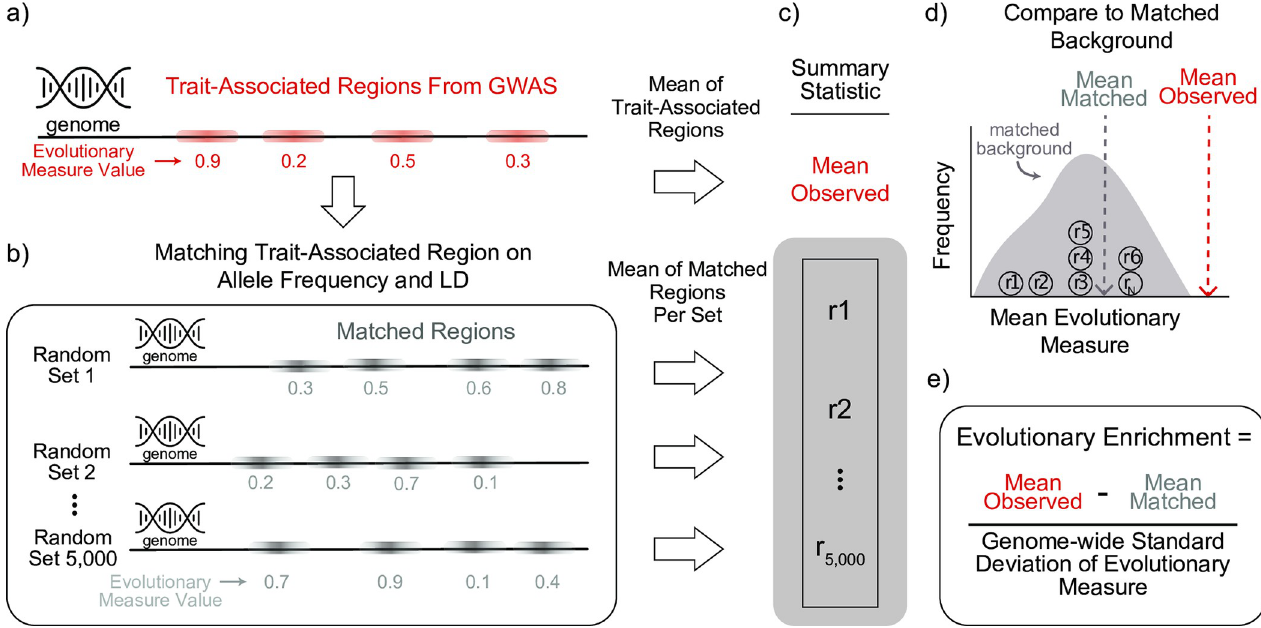
Fig 1. Computational framework for detecting positive and negative enrichment for evolutionary signatures on genome-wide association studies (GWASs). (a) Given the GWAS of a complex trait, we define trait-associated regions by first identifying variants of genome-wide significance and then clumping based on linkage disequilibrium (LD; e.g., r2 > 0.9). For each region, we identify the maximum value of an evolutionary measure of interest. (b) For each trait-associated region, we identify 5,000 randomly selected genomic regions (“matched regions”) that have similar minor allele frequency, linkage disequilibrium, and gene proximity patterns (Methods). (c) Across the trait-associated regions and their matched random genomic regions, we calculate a summary statistic. To illustrate our approach, we take the mean of the evolutionary measure to generate an (d) empirical background distribution and (e) calculate enrichment by comparing the mean observed evolutionary measure to the mean of the matched background distribution. We divide by the standard deviation of the evolutionary measure across the genome to standardize the enrichment. However, any summary statistic of interest could be used.